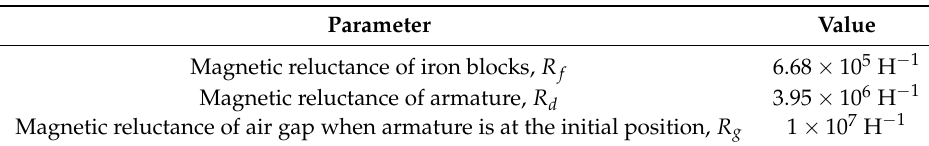
Table 2. Major parameters for numerical simulation.